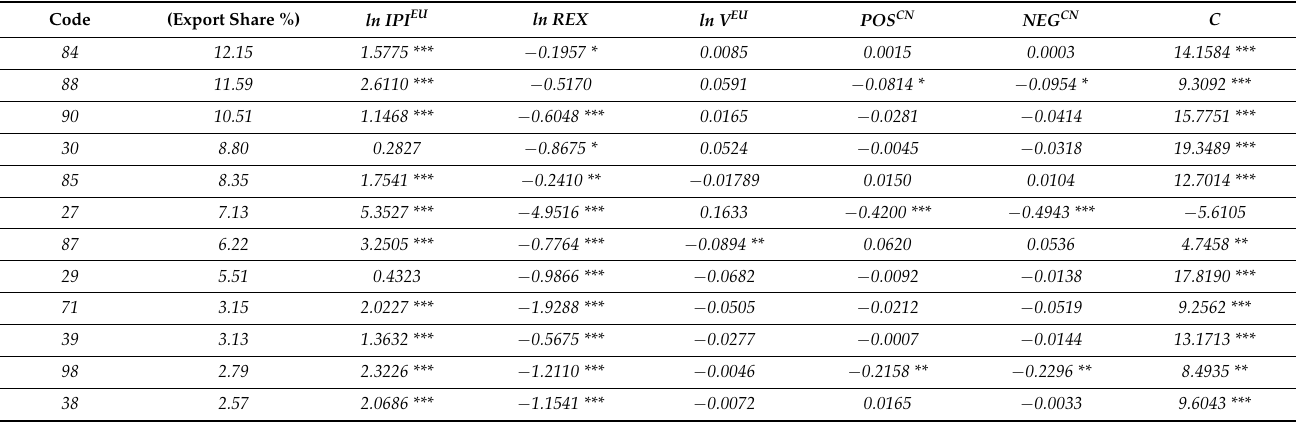
Table 8. Long-run coefficient estimates on the US exports to the EU with third country effects in the nonlinear ARDL Model (8).